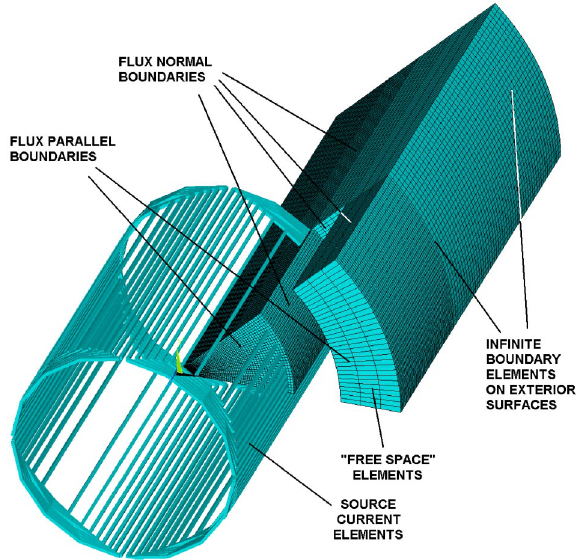
FIG. 15. (Color) Symmetrical magnet model with a half octant shown.